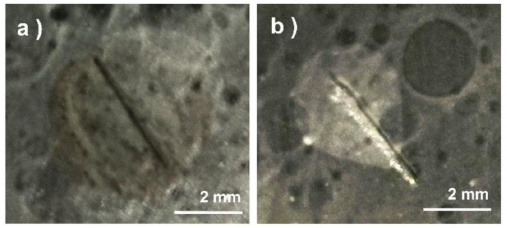
Figure 9. The digital pictures of the artificial scratch coating after corrosion resistance test: ( a ) Pure epoxy coating, ( b ) self-healing